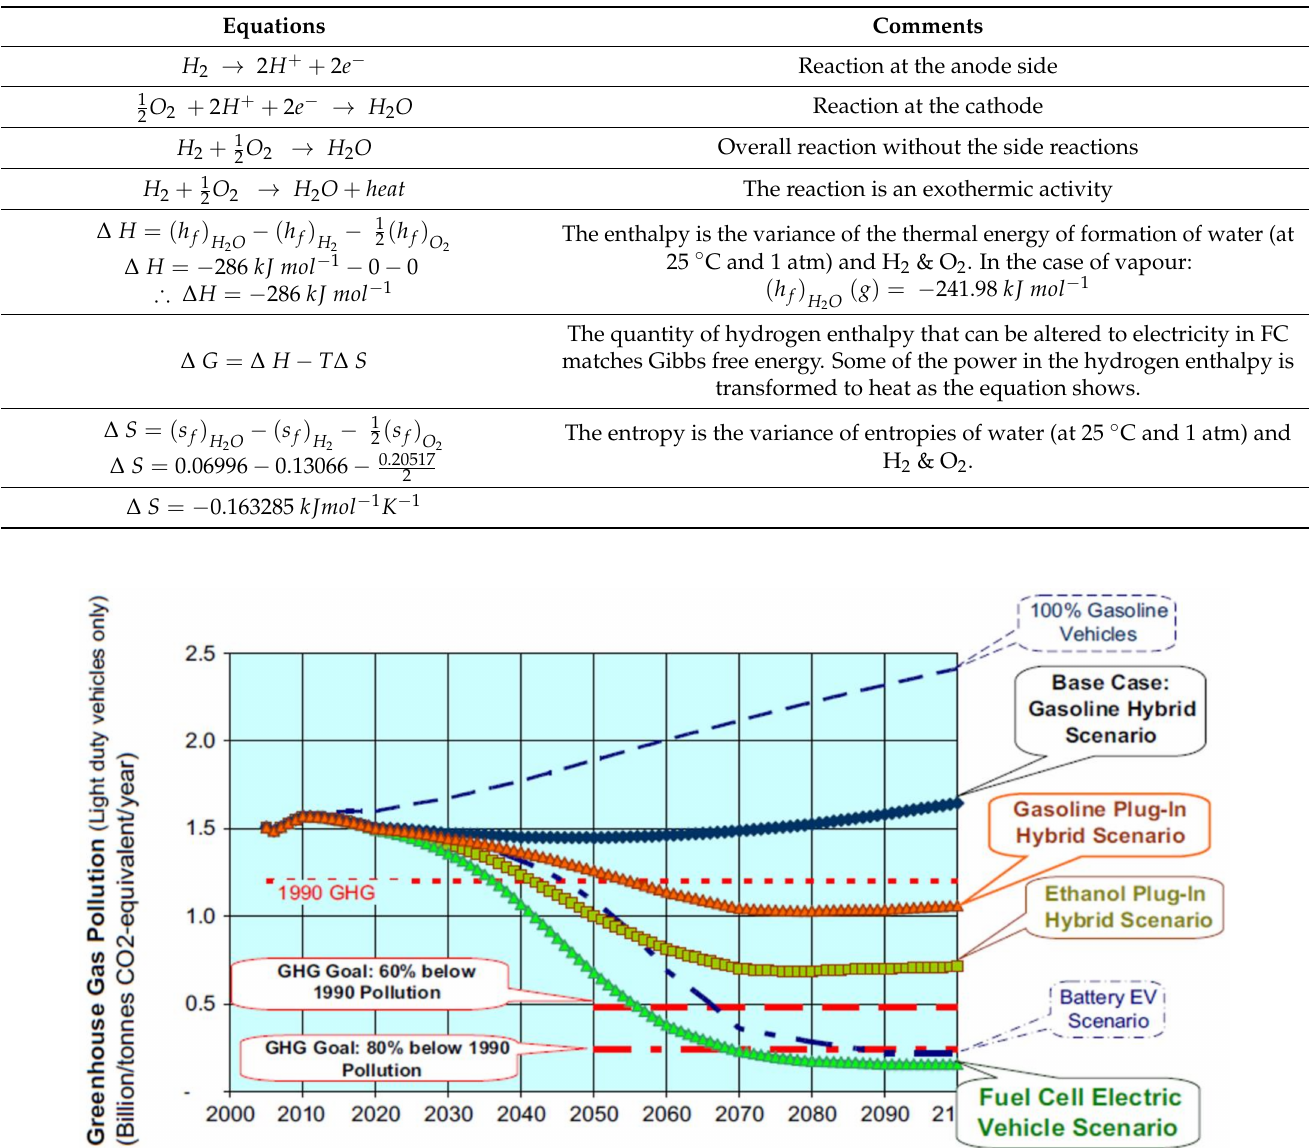
Table 3. Thermodynamic equations for proton-exchange membrane fuel cells [57].